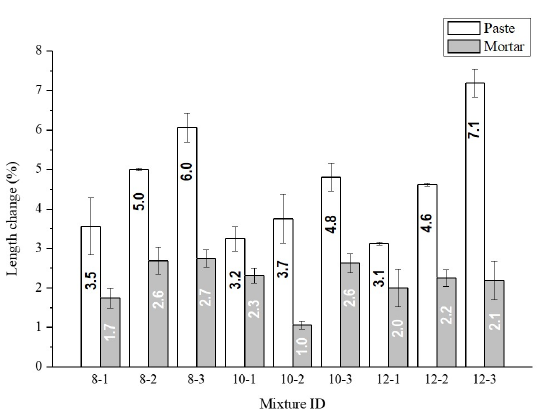
Figure 4. Length change of alkali-activated specimens.